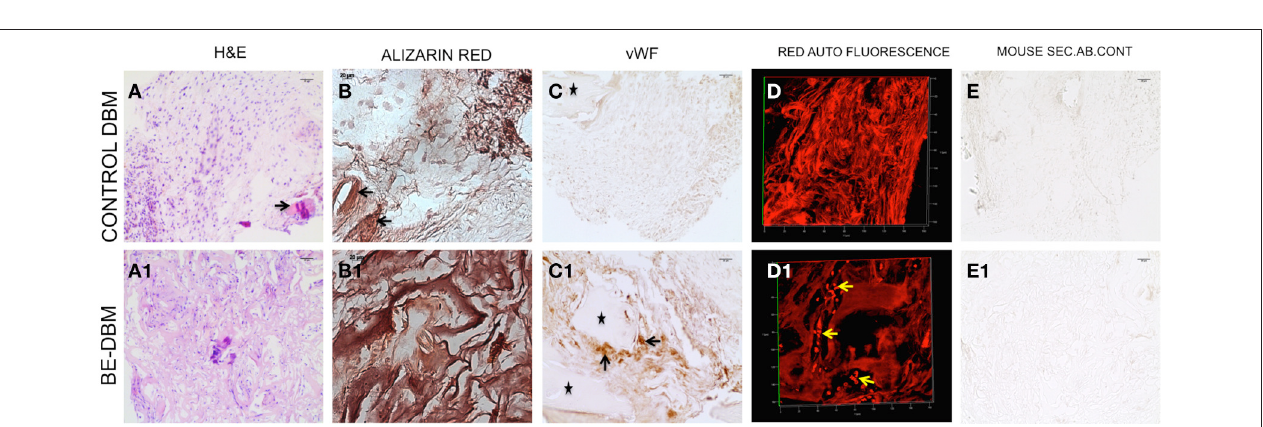
FIGURE 6 | Immunohistochemistry of DBM and BE-DBM in vivo explants. All images except secondary antibody controls (F,F1) are 3D renderings of z-stack confocal images. Scale bar in (F,F1) represents 20 µ m. The 3D images represent expression of osteocalcin (OCN, A,A1 ), DMP1 (B,B1) , TGF β 1 (C,C1) , BMP2 (D,D1) , and RUNX2 (E,E1) in DBM (A–E) and BE-DBM (A1–E1) samples after 2 weeks of subcutaneous implantation with HMSCs in immunocompromised mice. Note the marked increase in the expression levels of all the proteins in the BE-DBM.